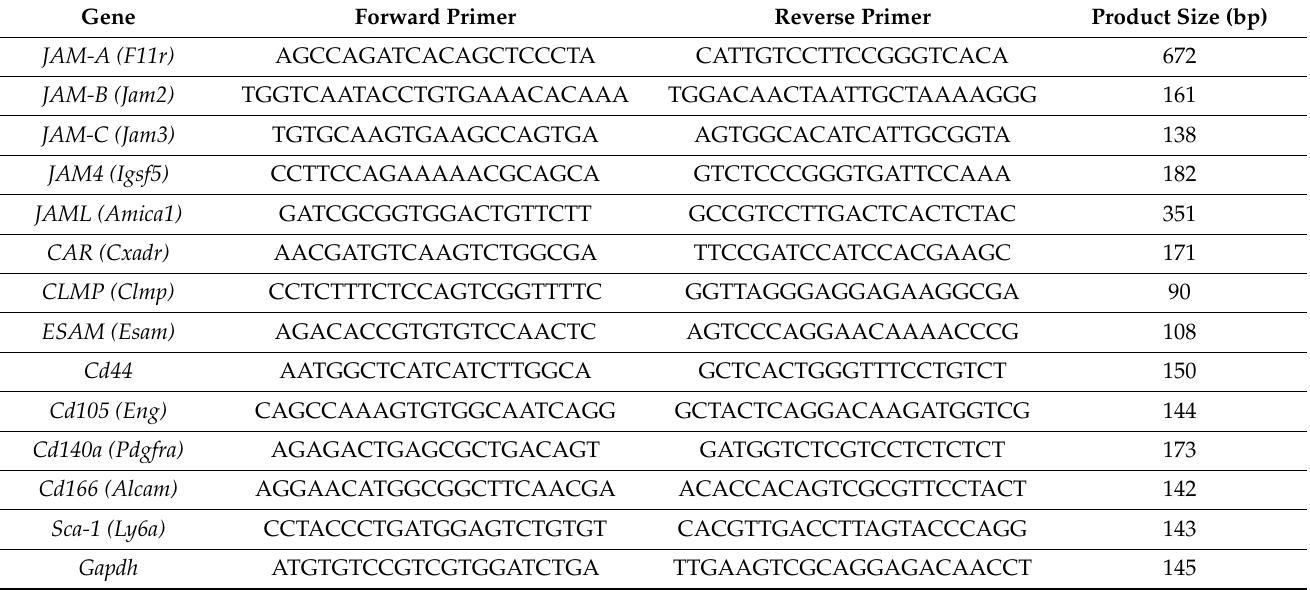
Table 2. Primers for